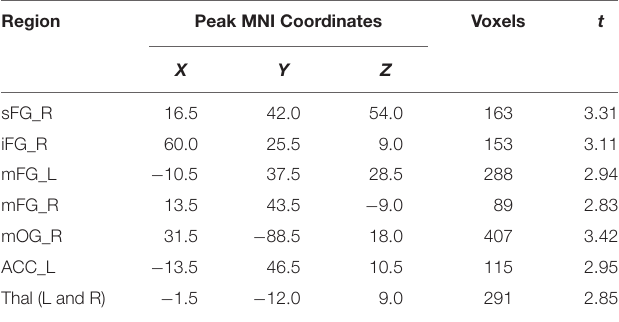
TABLE 2 | Notable gray matter volume (GMV) differences between mobile phone dependent (MPD) group and control group (MPD group < control